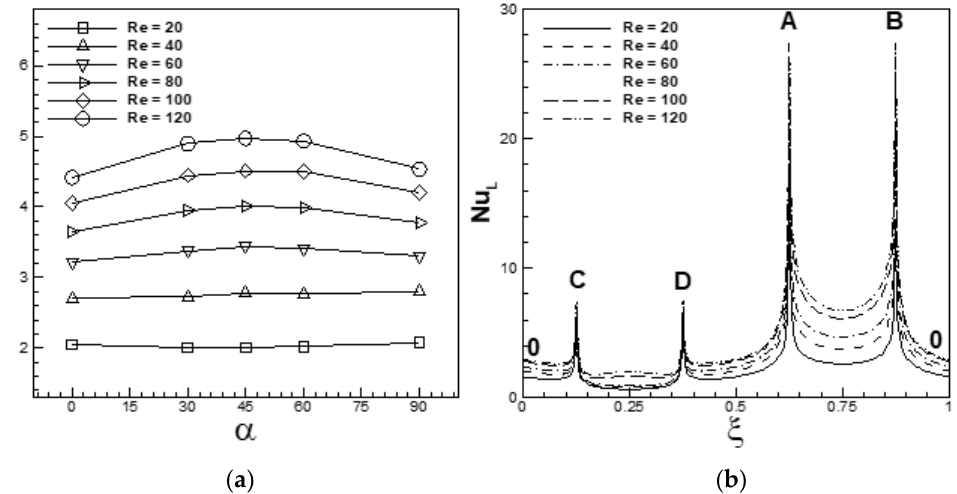
Figure 30. ( a ) Variation of the mean/steady Nusselt number with free-stream orientation for Ri = 0, 20 ≤ Re ≤ 120, 0° ≤ α ≤ 90° and ( b ) Time mean local Nusselt number along the surface of cylinder for α = 0 °, Ri = 0, 20 ≤ Re ≤ 120.